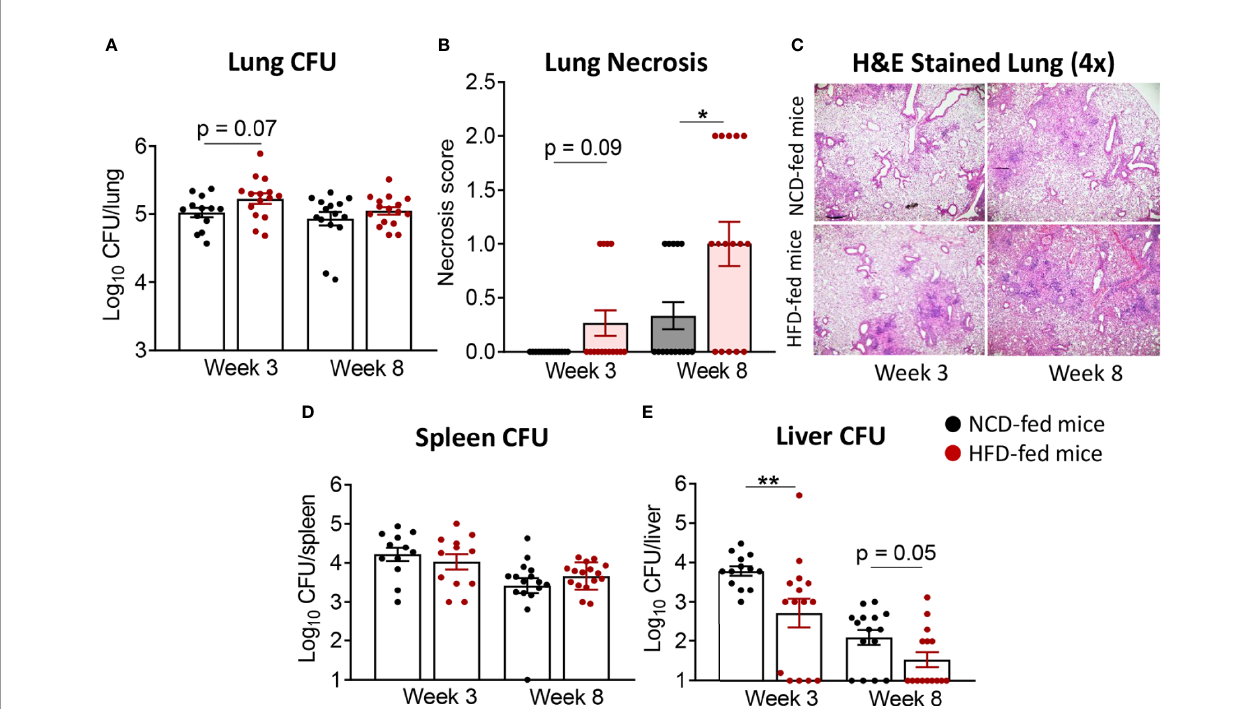
FIGURE 2 | Pre-diabetes increases lung pathology in Mtb-infected mice. (A) Lung Mtb burden in NCD- (black) and HFD-fed mice (red) at 3- and 8-weeks p.i.; (B) Lung Necrosis scores; (C) Representative lung histological images at 4x magni fi cation; (D) Mtb burden in spleen and (E) in liver. Data are means ± SEM (n=13- 16 mice/group) analyzed cumulatively in two independent experiments. Data analysis was performed by Mann-Whitney U test. ns = not signi fi cant *p < 0.05, and **p <